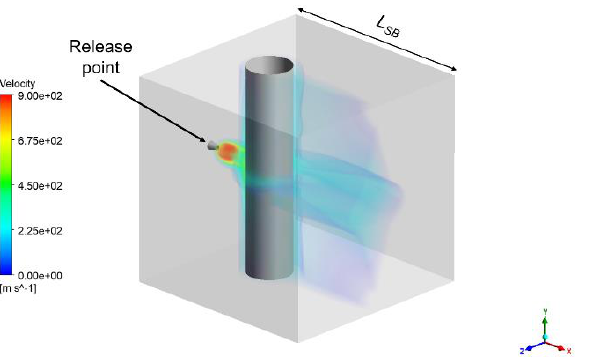
Figure 6. The 3D visualization of the jet flow velocity in the SB. SB shapes are depicted in light grey and the release point and SB obstacle are depicted in dark grey.